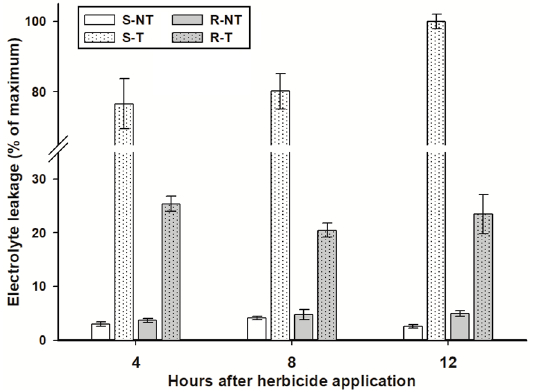
Figure 3. Percentage of electrical conductivity in leaf segments with respect to total electrolytes of susceptible (S) and resistant (R) Eleusine indica plants from Colombia, non-treated (NT), and treated (T) with 200 g ai ha − 1 paraquat. Histograms represent the means and vertical bars of the standard error ( n = 8).